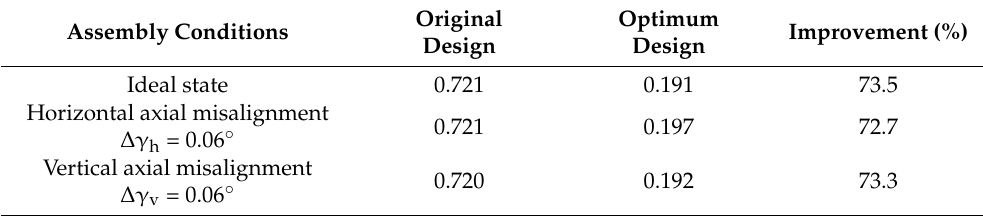
Table 4. Optimum tip relief modification parameters.